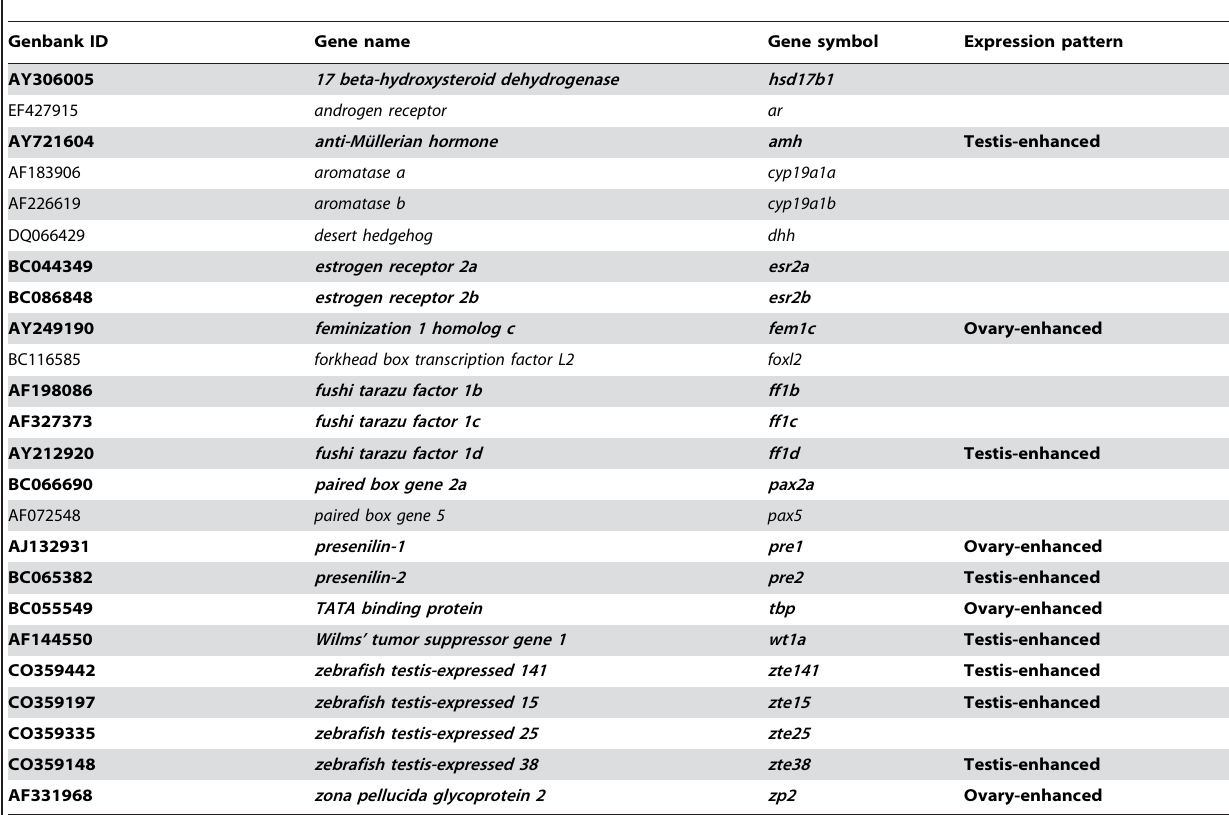
Table 1. The list of the 24 candidate genes on the Gonad Uniclone Microarray, with their expression patterns indicated*.